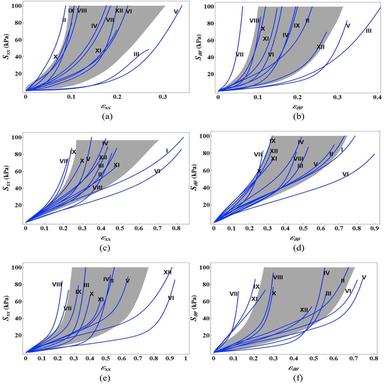
Uniaxial tensile tests (loading curve) of the axial and circumferential strips for intima, media and adventitia from all considered donors. The roman numbers identify the donor. 2nd Piola-Kirchhoff stresses versus Green's strains are shown. The gray area is within one standard deviation distance from the average curve obtained from all the experimental data for that specific layer and direction. (a) Intima axial; (b) intima circumferential; (c) media axial; (d) media circumferential; (e) adventitia axial; (